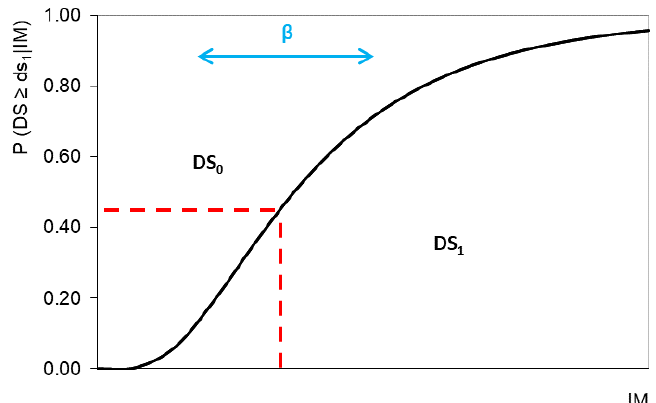
Figure 1. Example of fragility curve representing the probability of exceeding damage state DS 1 (modified after [36]).